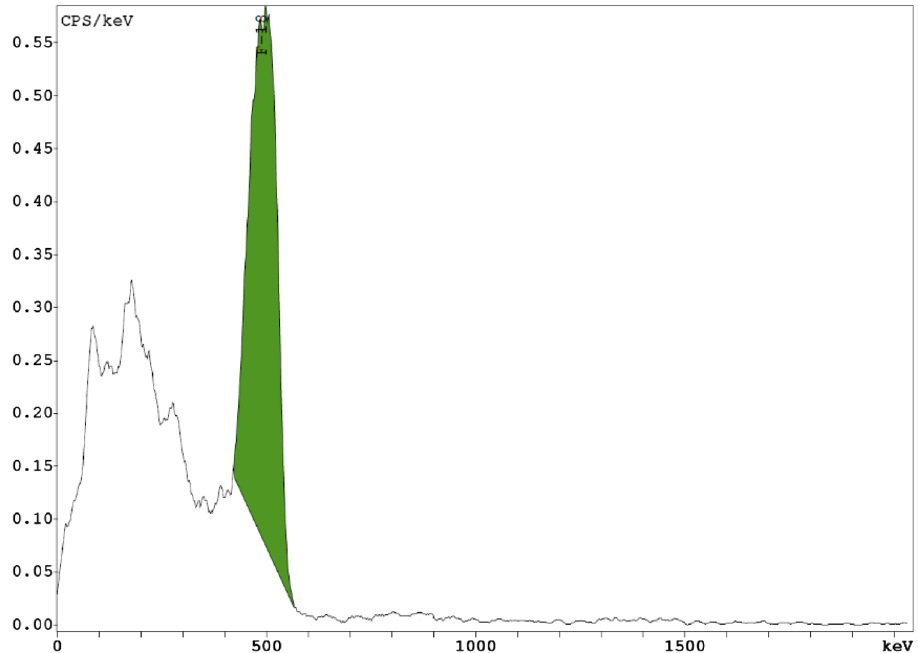
Fig. 3 Gamma spectroscopy data of a decayed [ 18 F] FDG